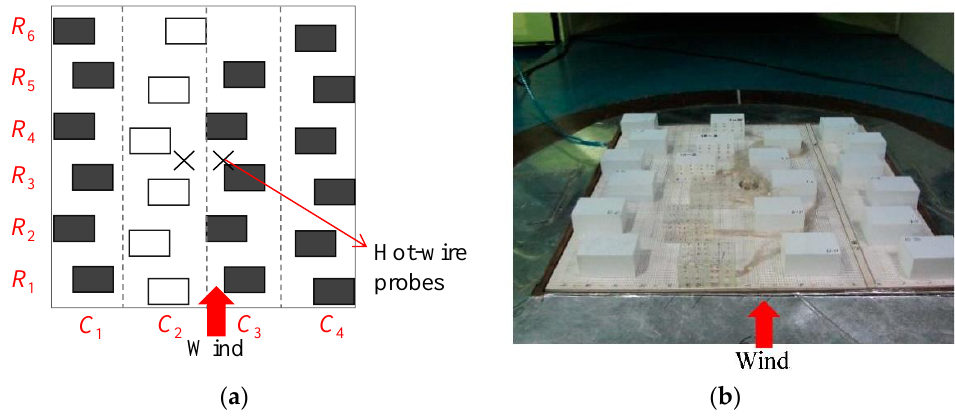
Figure 7. Schematic diagrams of model arrangement. ( a ) Plan view. Surface pressure data on the windward and leeward sides of C 2 were measured. ( b ) Isometric view. Cross marks denote the horizontal locations of two hot-wire probes.